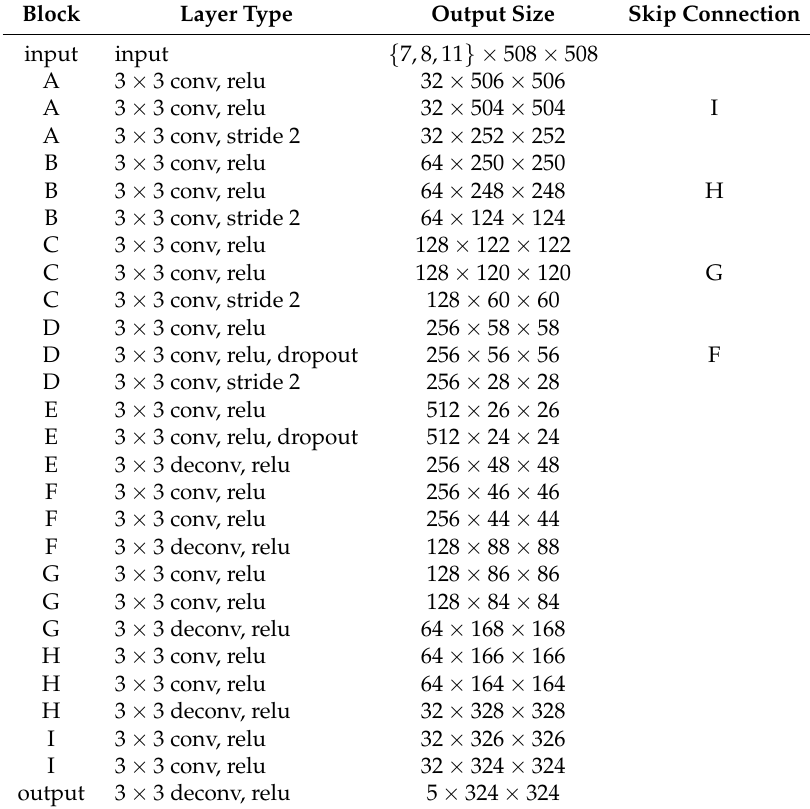
Table 2. Architecture for cloud